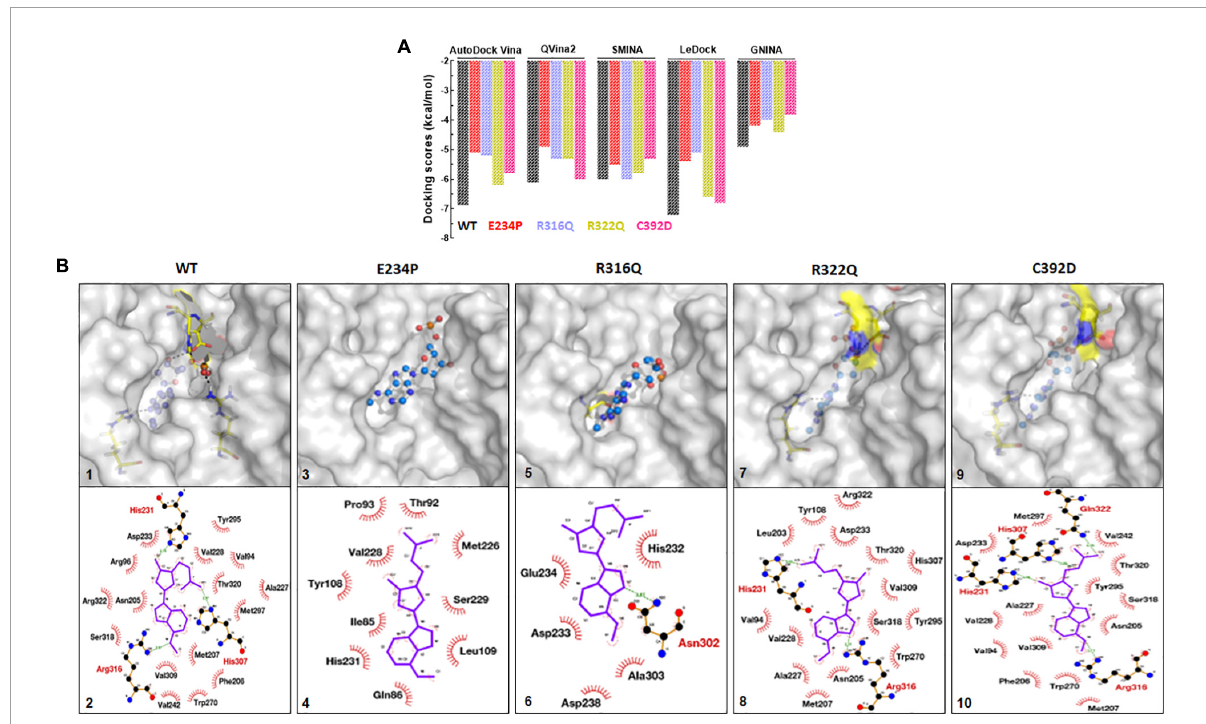
FIGURE8 Protein-ligand docking and interactions analyses of WT and MTs. (A) Docking scores from AutoDock Vina, QVina2, SMINA, LeDock and GNINA docking tools. (B) 3D and 2D interaction maps of (1) and (2) WT-6mA, (3) and (4) E234P-6mA, (5) and (6) R316Q-6mA, (7) and (8) R322Q-6mA and (9) and (10) C392D-6mA. WT, E234P, R316Q, R322Q and C392D were labeled in black, red, blue, mustard, and magenta color, respectively. In 3D interaction map, protein and ligand were shown in surface and ball and stick mode, respectively. In 2D interaction maps ligand shown in blue color and hydrophilic and hydrophobic interacting residues were labeled in red and black